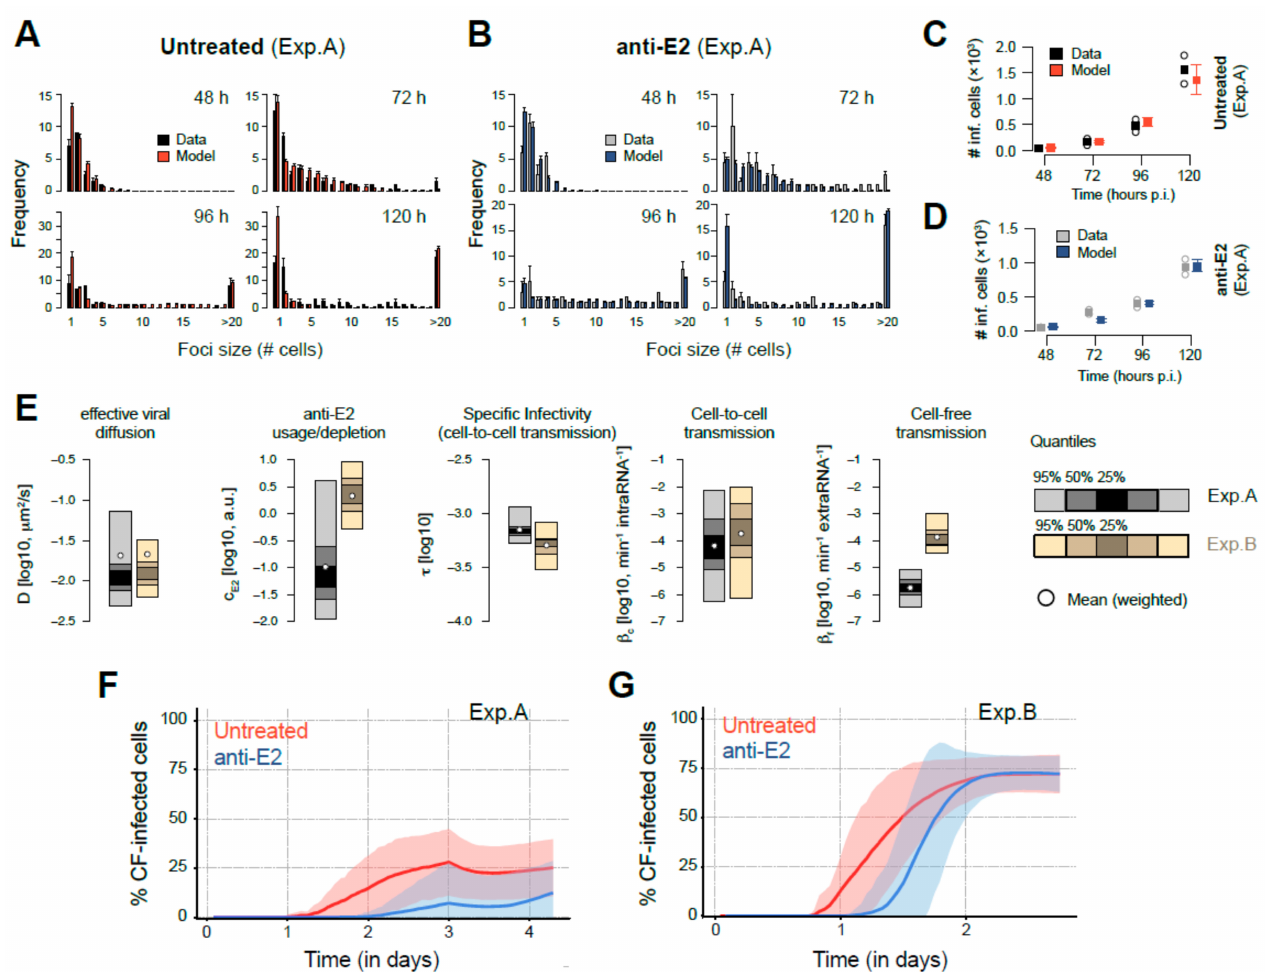
Figure 4. Model fits, parameter estimates, and relative contribution of cell-free and cell-to-cell transmission modes to HCV spread: ( A , B ) Measured (black/grey) and predicted (red/blue) focus size distributions for Exp. A in the absence ( A ) and presence ( B ) of anti-E2 at 48, 72, 96, and 120 h p.i. and calculated across two replicates (=wells) according to the experimental conditions. Predictions are based on an exemplary parameterization of the model as obtained by the fitting procedure. ( C , D ) Measured (black/grey) and predicted (red/blue) average number of infected cells in untreated ( C ) and anti-E2 treated ( D ) wells calculated across two replicates (=wells). ( E ) Credibility intervals for the individual parameter estimates obtained by the high-performance computing approach (pyABC) for Exp. A (black/grey) and Exp. B (orange/wheat) after 15 generations of optimization. White circles indicate the weighted mean for each parameter. Corresponding estimates are shown in Table 1. ( F , G ) Predicted proportion of cells infected by cell-free transmission for Exp. A ( F ) and Exp. B ( G ) over the course of the experiment. Mean (solid lines) and 95% CI (shaded area) as calculated from all model predictions obtained from the best performing parameter combinations (=particles) with a distance smaller than 4.0, i.e., 10–15 particles, for untreated (red) and anti-E2 treated (blue) simulations. Please note that time courses denote the time point of infection of cells and need to be shifted by 18 h to be related to the empirical data, as a time delay of 18 h was considered to account for the delay between infection and experimental detection of infection (see Section